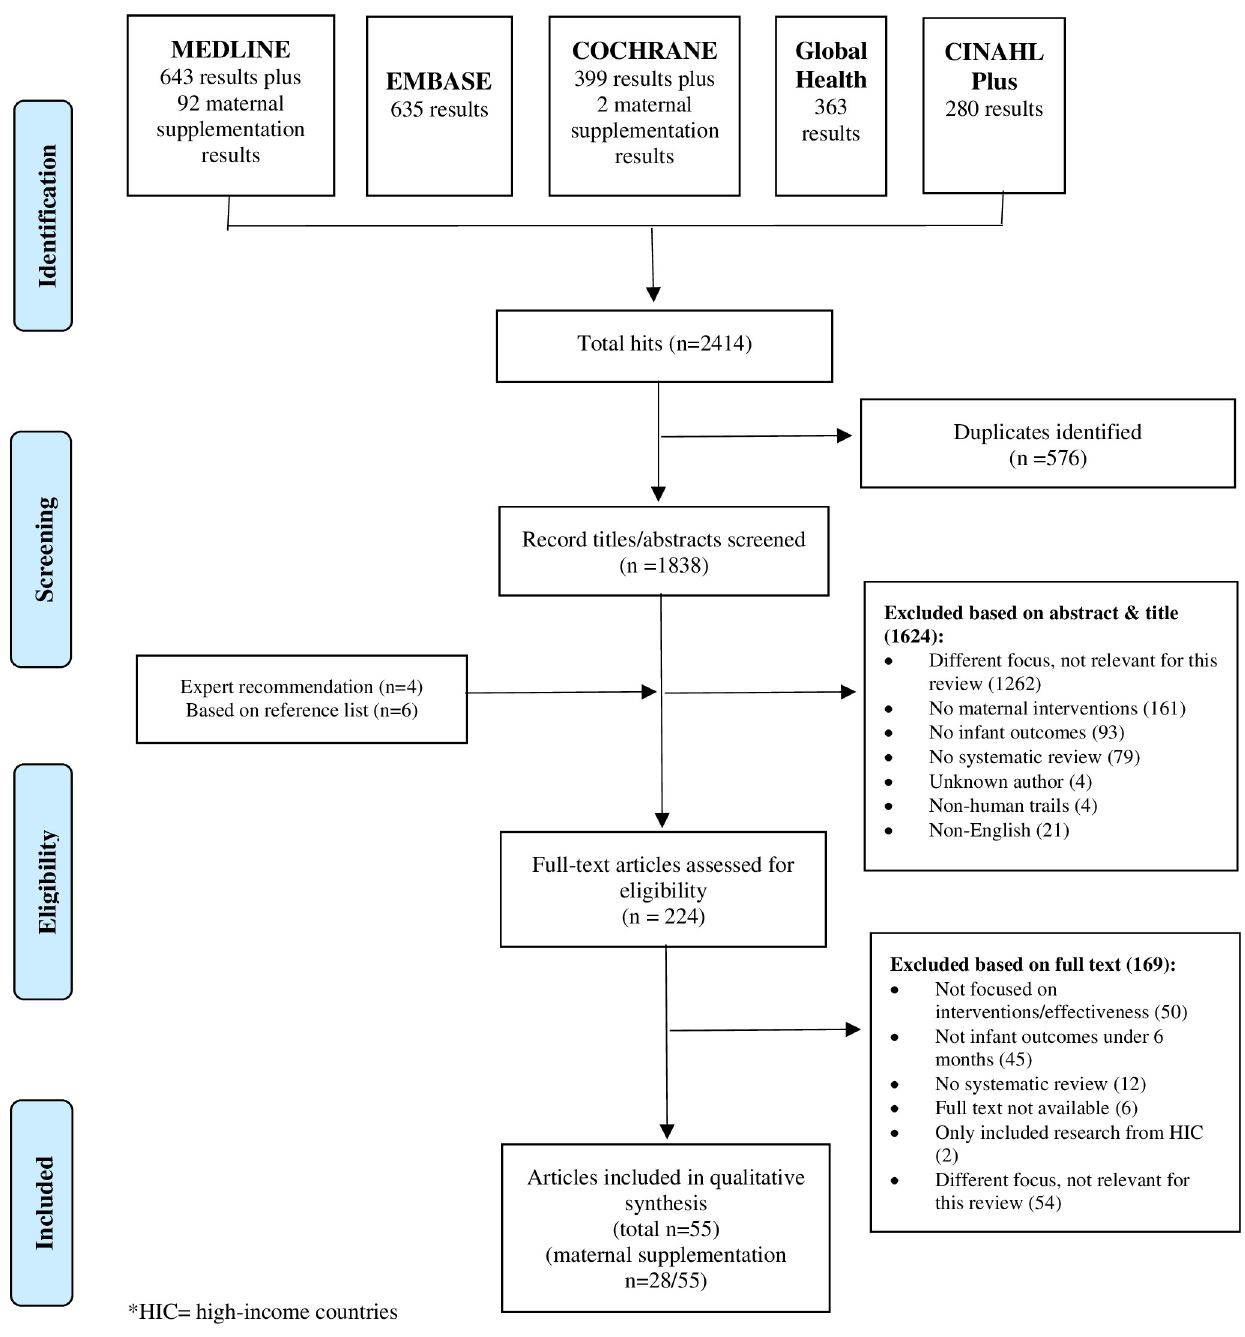
Fig 1. PRISMA flow diagram of search